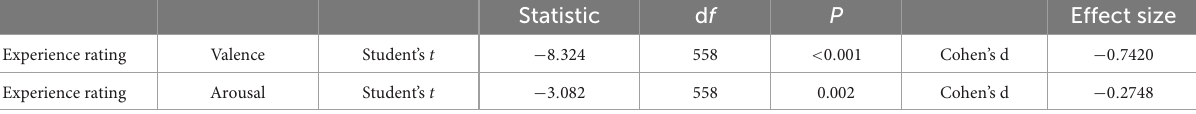
TABLE 3 Independent samples T -test for valence and arousal